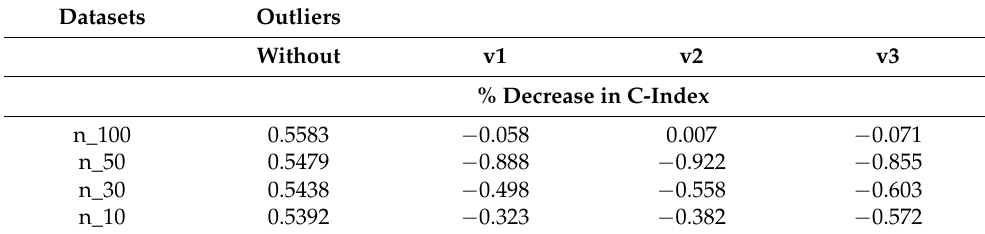
Table 7. FRSF Performance with Outlier Examples.